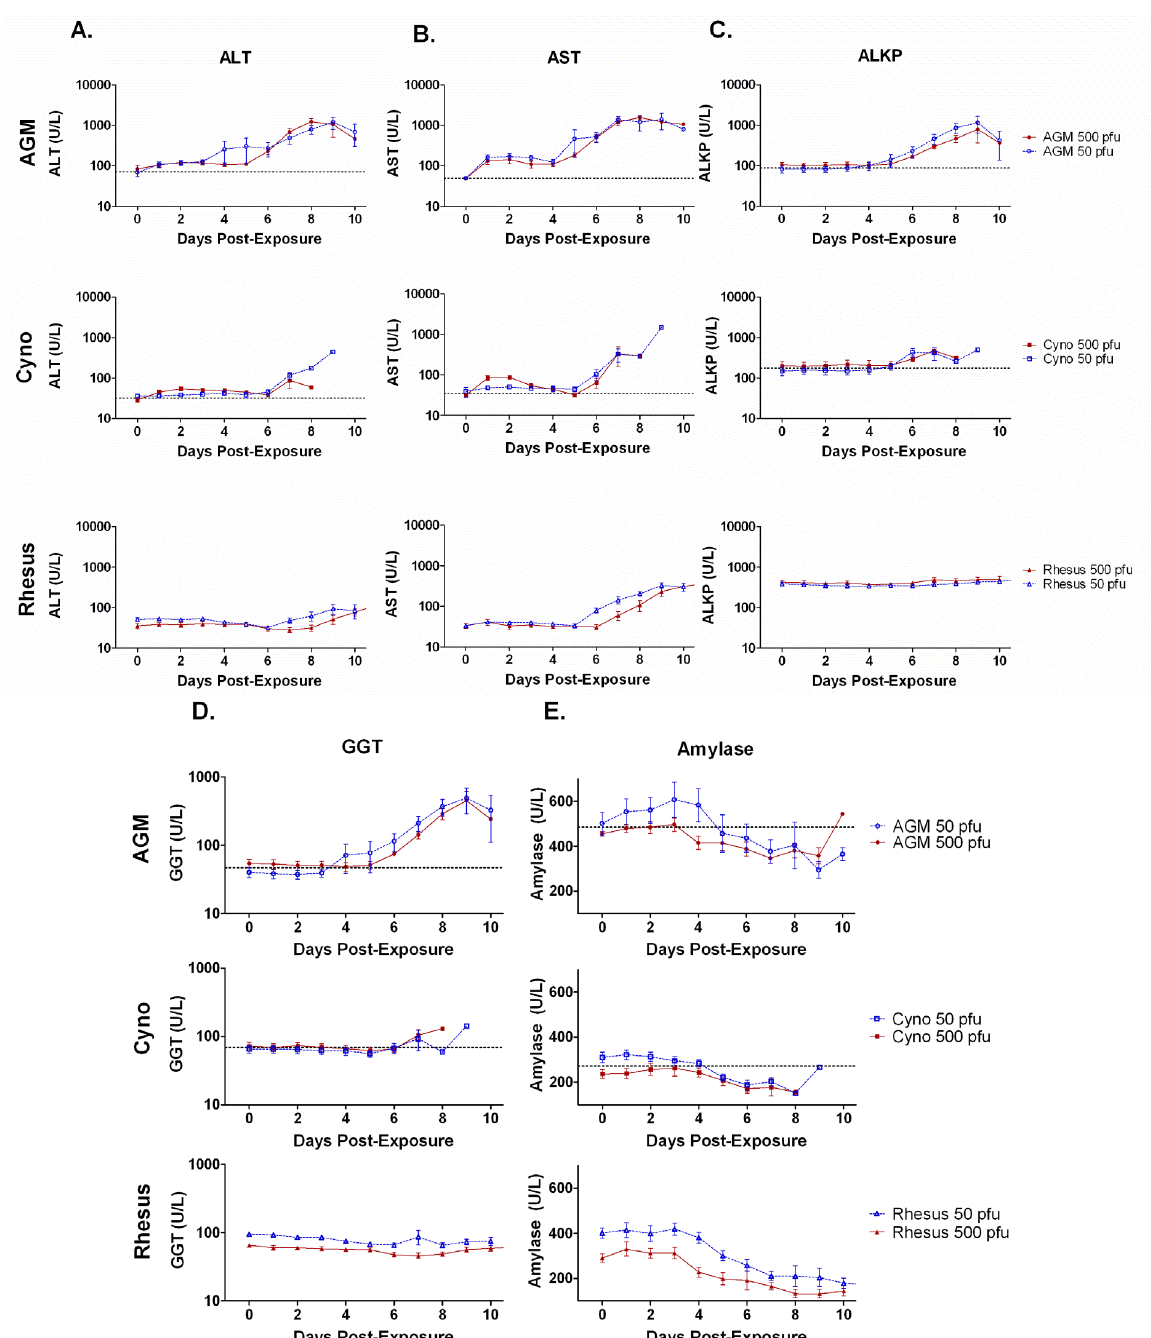
Figure 5. Average alanine transaminase (ALT), aspartate transaminase (AST), alkaline phosphatase (ALKP), gamma-glutamyltransferase (GGT), and amylase concentrations in NHPs exposed to aerosolized SUDV. Graphs are shown for the group averages of A ) ALT, B ) AST, C ) ALKP, D ) GGT, and E ) amylase in three NHP species after exposure to two different doses of aerosolized SUDV. Average measurements on day 0 were taken before exposure serve as a baseline. There were six animals per group. Error bars represent the standard error of the mean. The horizontal dashed line indicates the average baseline (day 0) for the 12 animals in both dosage groups. AGM groups had significant changes in all parameters ( p ≤0.01) excep t the AGM 50 pfu group for amylase. Cyno groups had significant increases primarily in ALKP ( p ≤0.01) and the 50 pfu group for amylase ( p <0.01). Rhesus groups had significant changes in AST and amylase ( p ≤0.01) but not for other